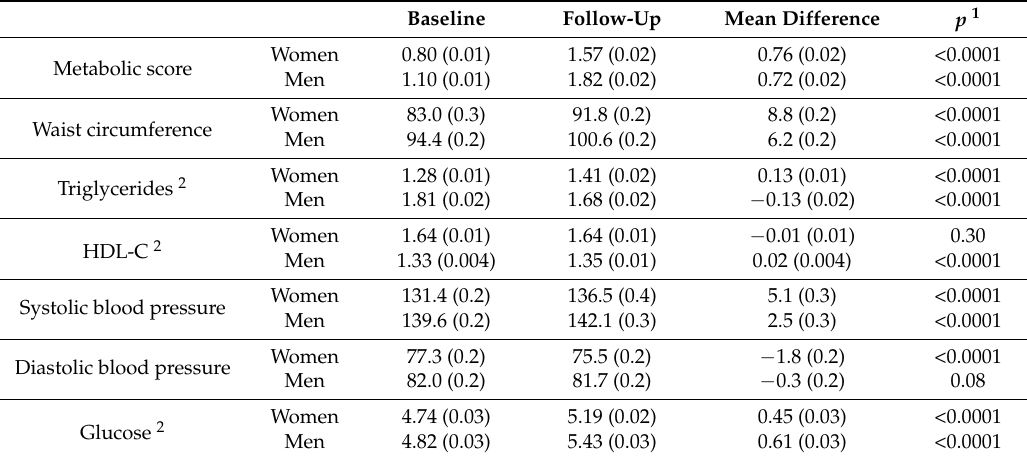
Table 4. Changes in metabolic score and components of metabolic syndrome from baseline to follow-up, mean